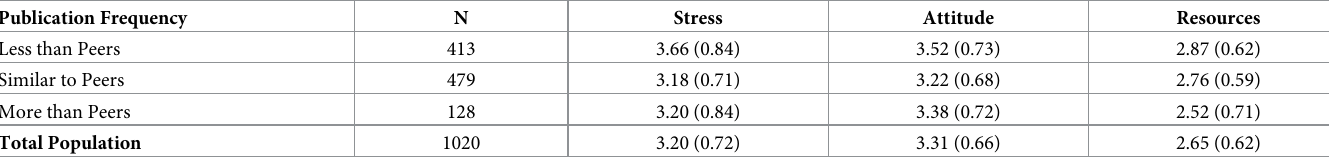
Table 5. Post-COVID publication pressure questionnaire subscale scores stratified by self-identified publication frequency.